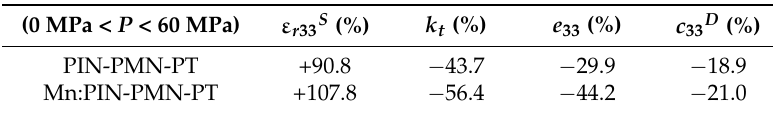
Table 3. Variation with P for two generations of piezocrystals, 0 MPa ď P ď 60 MPa (Reference P = 0 MPa).